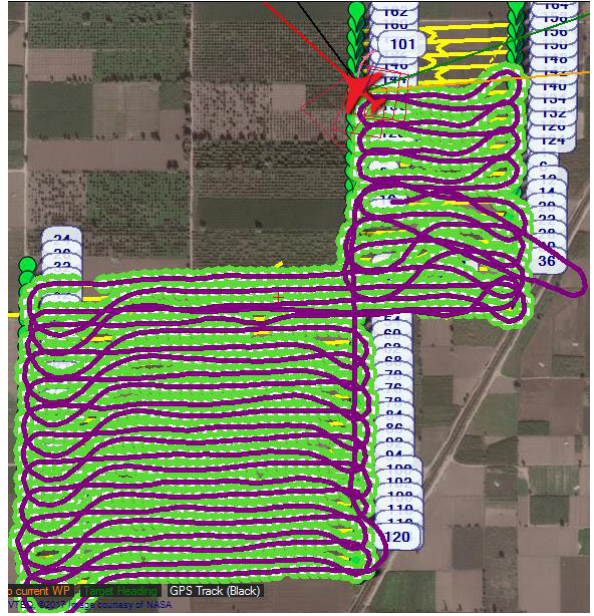
Figure 4. Planned and logged trajectory of a flight